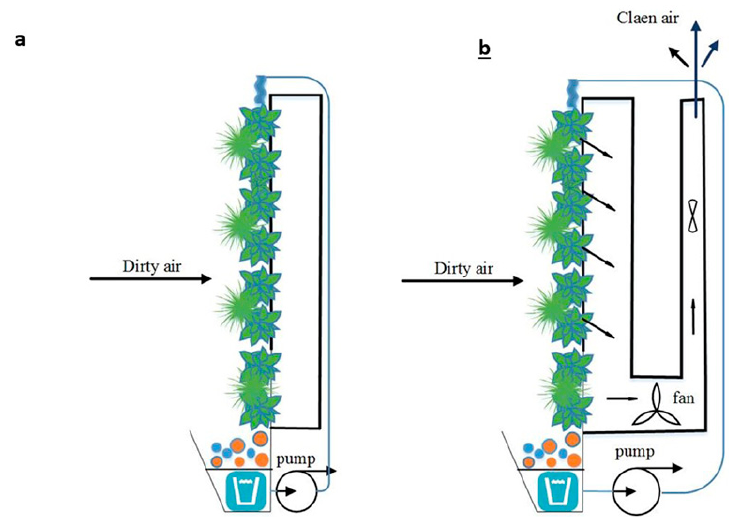
Figure 2. ( a ) Passive and ( b ) active living wall or biofiltration system; adapted from [109] .